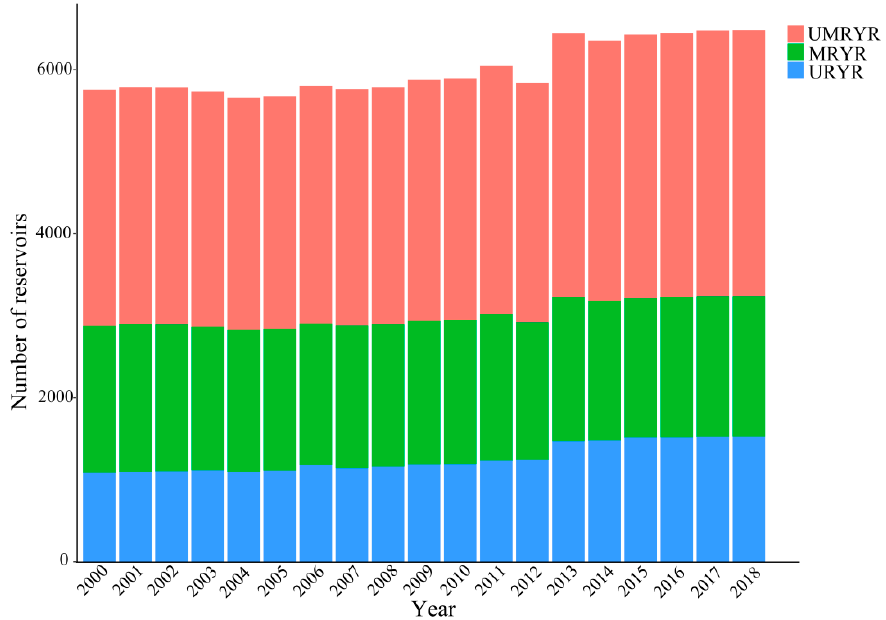
Figure 9. Twenty-year comparison and trend analysis of the reservoirs in the UMRYR for 2000–2018. The URYR and MRYR indicate the upper reaches of the Yellow River and the middle reaches of the Yellow River, respectively.